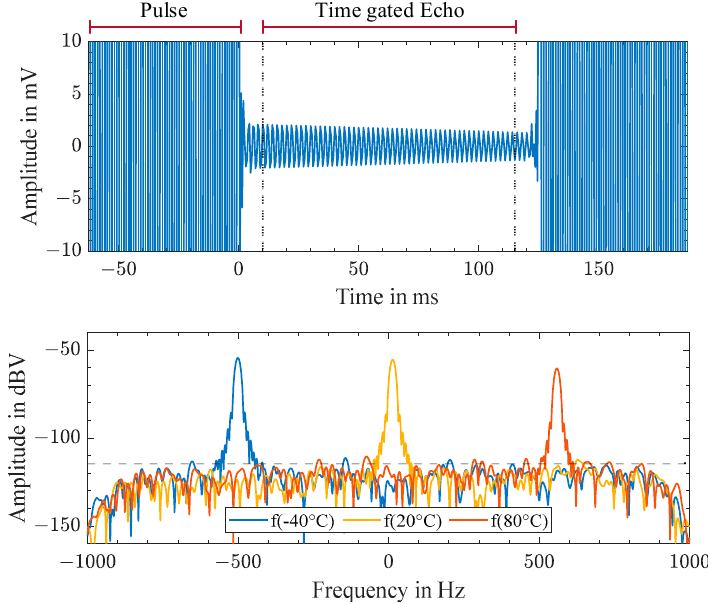
Figure 5. Sampled time-domain signal after down-conversion for a high-Q resonator at − 40 °C with excitation pulse at 𝑡 < 0 ms and backscattered echo starting at 𝑡 = 0 ms ( top ). Fourier transform of the time-gated echo signal between 10 ms and 115 ms for three different temperatures of the tuning fork resonator: in blue for − 40 °C, in yellow for +20 °C, and in orange for +80 °C ( bottom ).